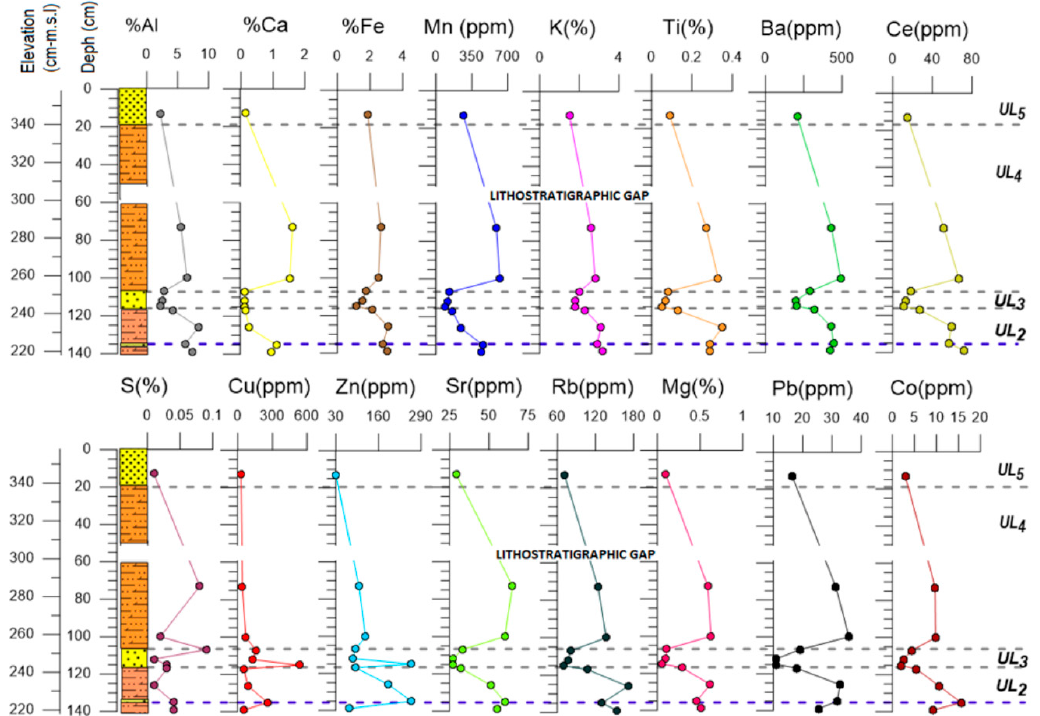
Figure 3. Vertical distribution of the geochemical elements of CF2 core.